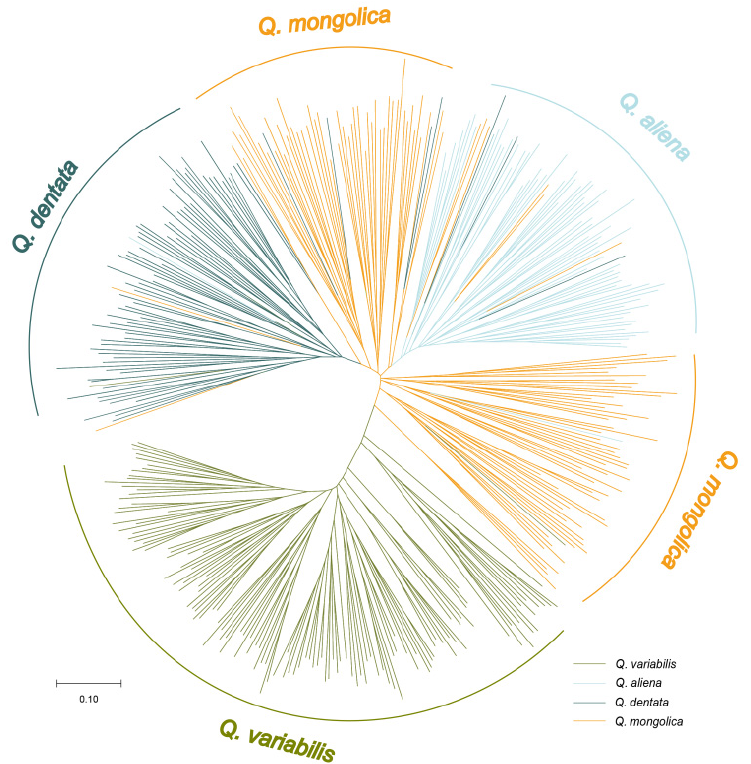
Figure 1. Neighbor-joining tree of 400 oak individuals from four species. Different colors indicate different species. The cluster of Q. variabilis (green), Q. aliena (blue), Q. dentata (cyan), and Q. mongolica (orange) is shown in the circle NJ tree. Length of lines show the genetic distance. The scale bar represents 0.1 genetic distance.